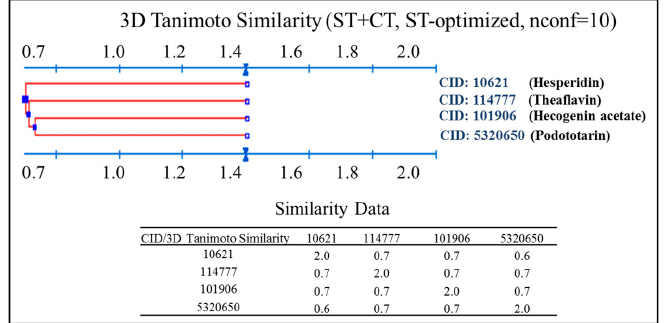
Figure 3. 3D Clustering analysis for evaluated NPs.